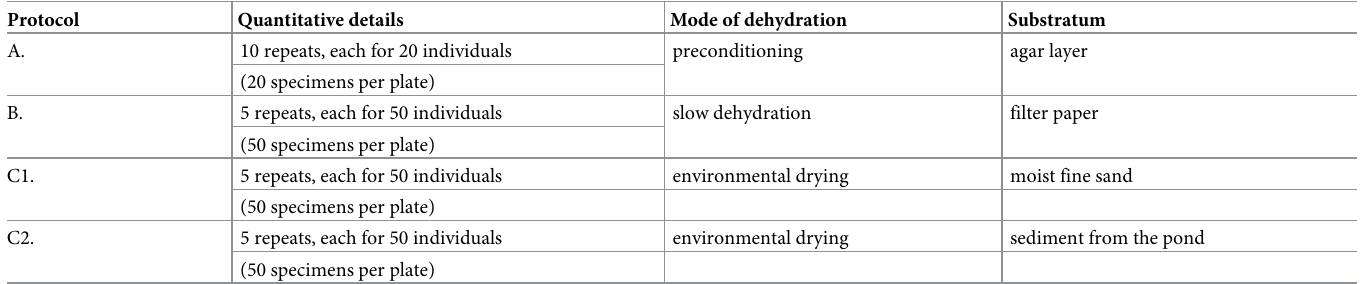
Table 1. Summary of the applied anhydrobiosis protocols. In the case of A and B protocols, each plate contained five additional specimens for tuns’ photography under stereomicroscope and tuns’ ultrastructure analysis under transmission electron microscopy.